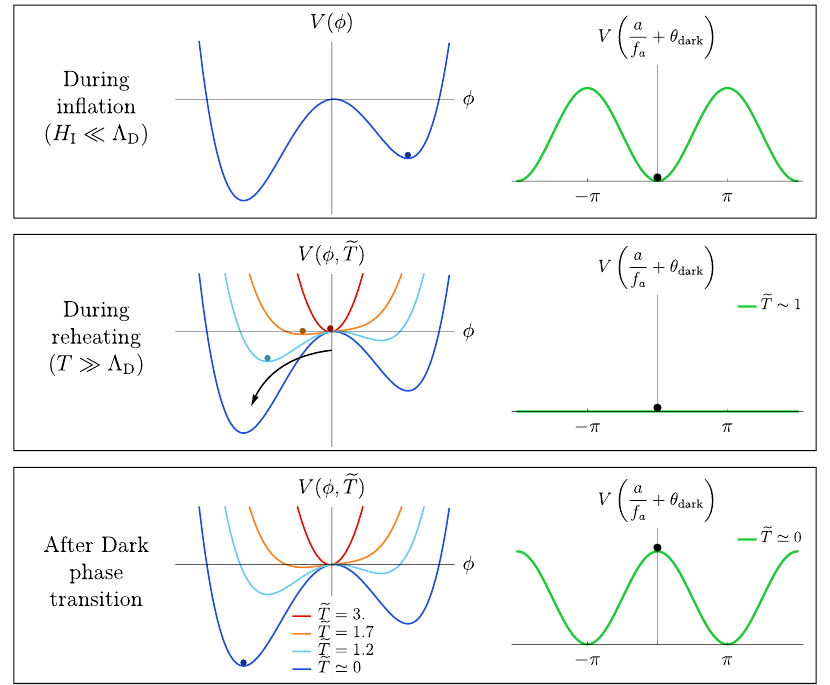
Figure 2 . Dynamics for the modulus, φ , and the axion field in the early Universe, adapted from [62]. Coloured lines show their potentials at different rescaled temperatures, defined as ˜ T = T µ − 1 λ 1 / 2 , and the corresponding dots represent the field values at those times. In this case, the modulus